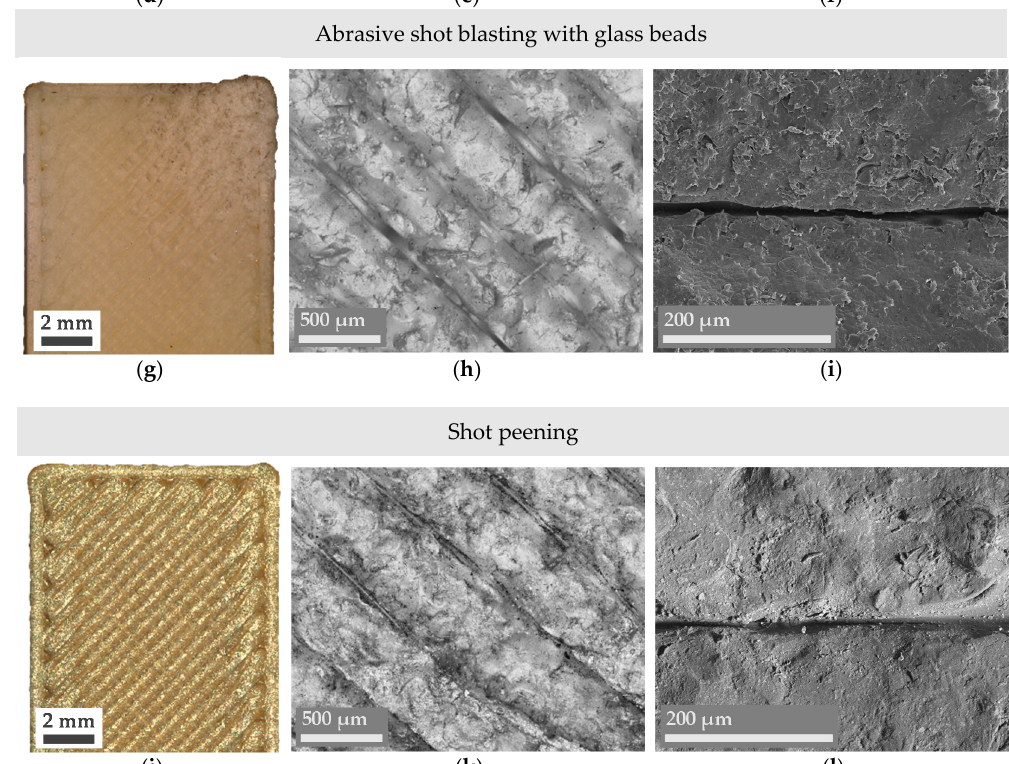
Figure 5. Digital microscope ( a , b , d , e , g , h , j , k ) and SEM micrographs ( c , f , i , l ) of the mechanically treated Ultem parts.